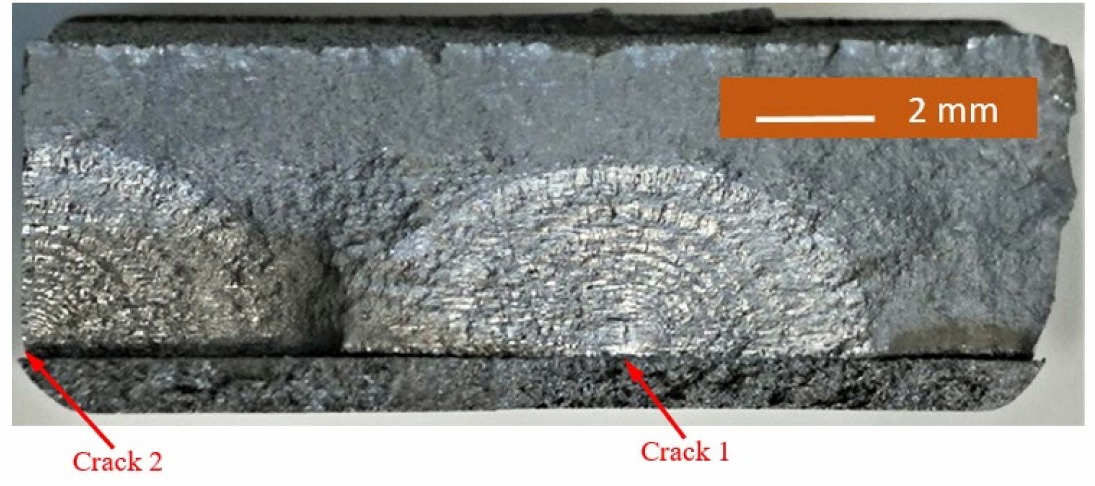
Figure 4. Failure surface associated with test specimen